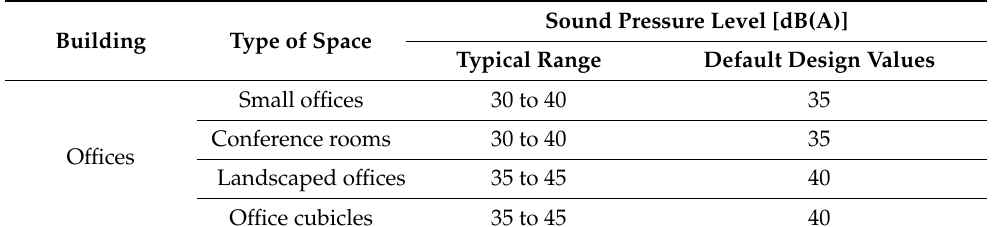
Table 1. Design A-weighted sound pressure levels recommended in SR EN 15251:2007 for office buildings.